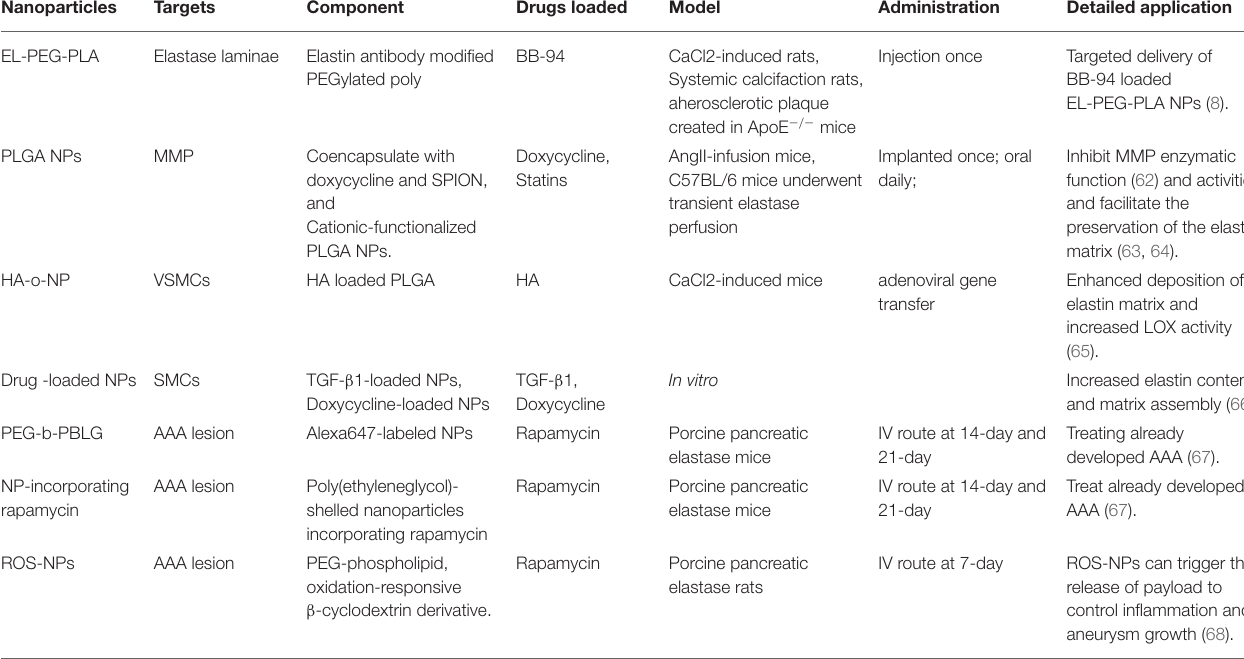
TABLE 2 | Nanoparticles in AAA